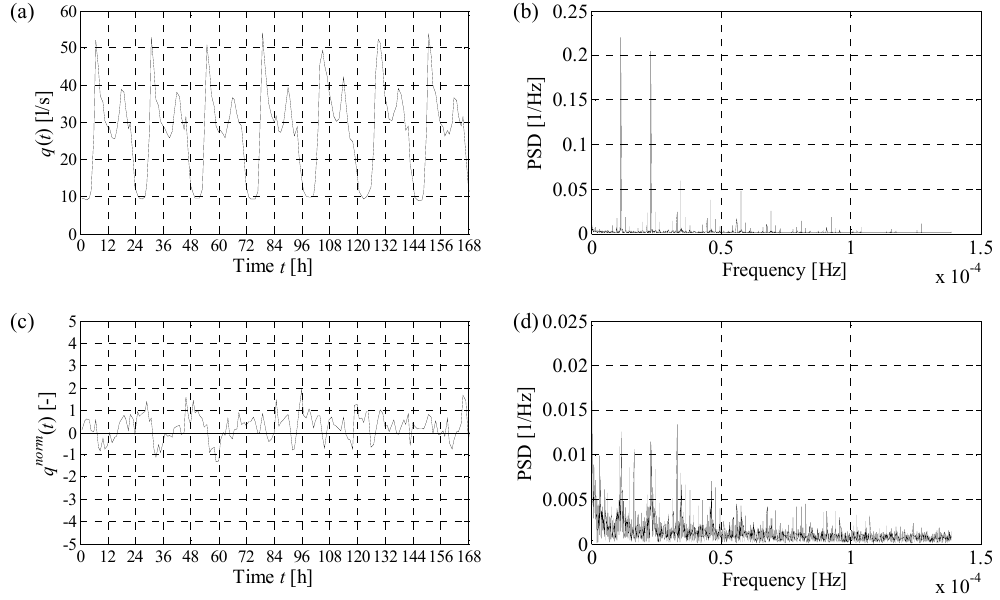
Figure 4. Comparison of ( a ) observed and ( c ) normalised hourly demands for a one-week period in DMA1 and the frequency analysis of the entire ( b ) observed and ( d ) normalised time series of DMA1. Two benchmark models were applied by way of comparison to the same datasets, in order to assess the accuracy of the forecasts provided by the NHMC and HMC models. The first benchmark model adopted was a multi-layer perceptron artificial neural network (ANN) model structured in such a way as to provide water demand forecasts for the next K = 24 h. The network has the same structure of the one proposed by Alvisi and Franchini [16], whose inputs are the water demands observed in the past 24 h, normalised in the same manner seen for the HMC model, scaled in the [0 1] interval, and assigned a binary code identifying the type of the day (working or non-working). The second benchmark model used is of the naïve type. The model has a decidedly simpler structure